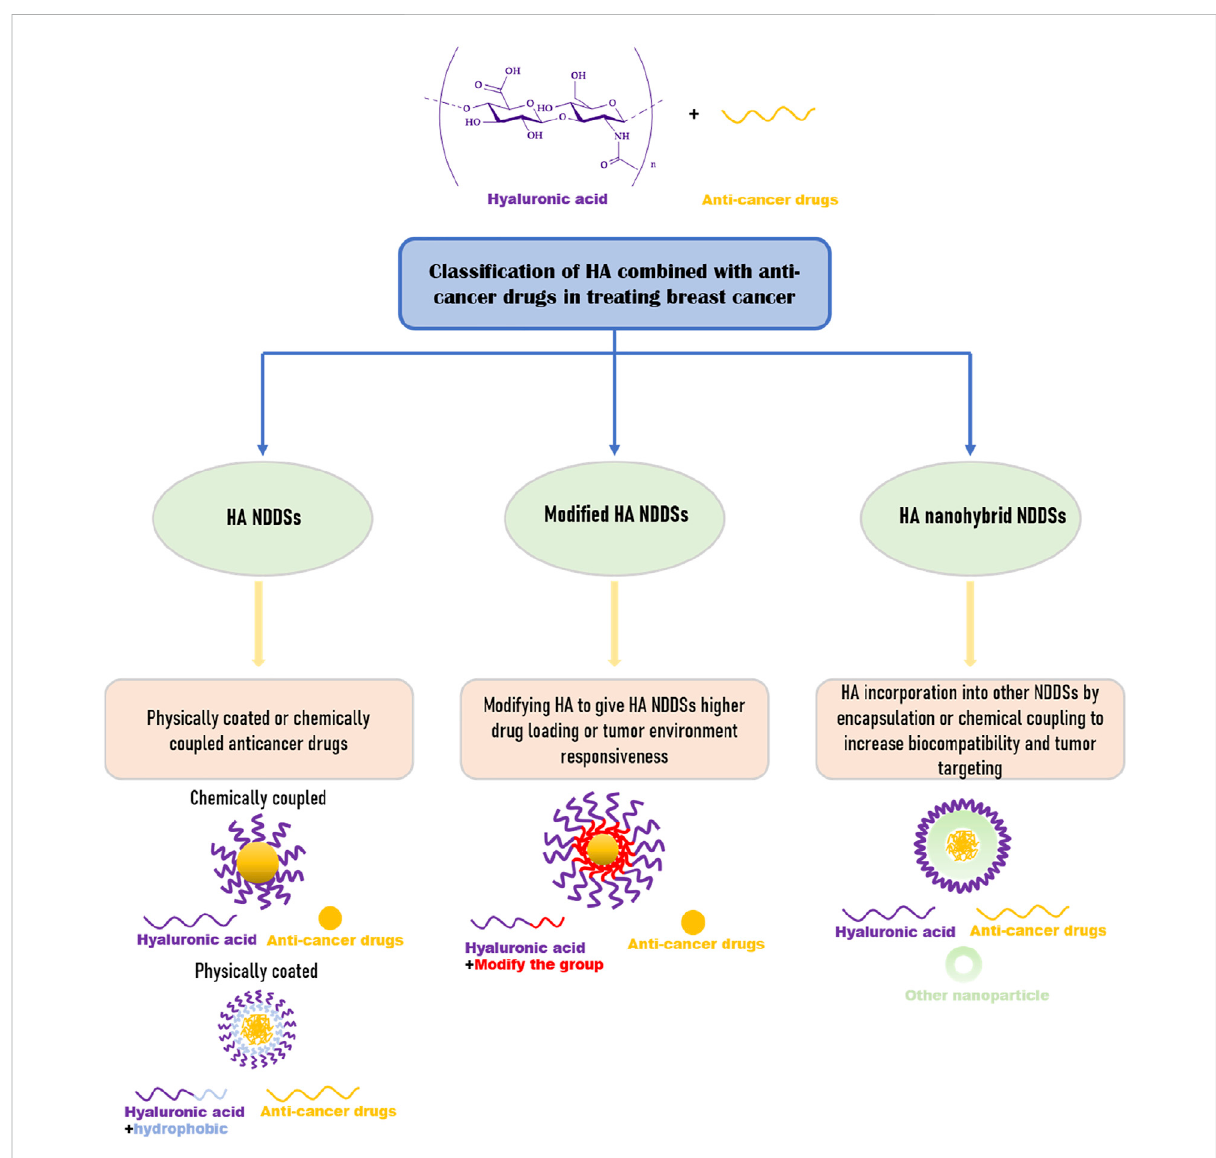
FIGURE 1 Classi fi cation of hyaluronic acid NDDSs in breast